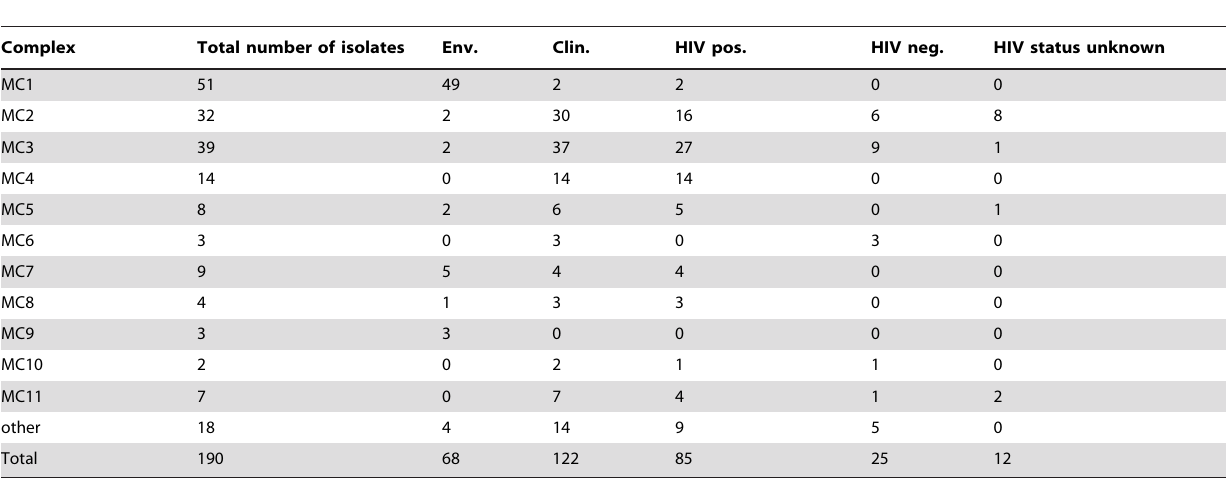
Table 4. Distribution of isolates from clinical (including HIV status) or environmental origin over the 11 microsatellite complexes.